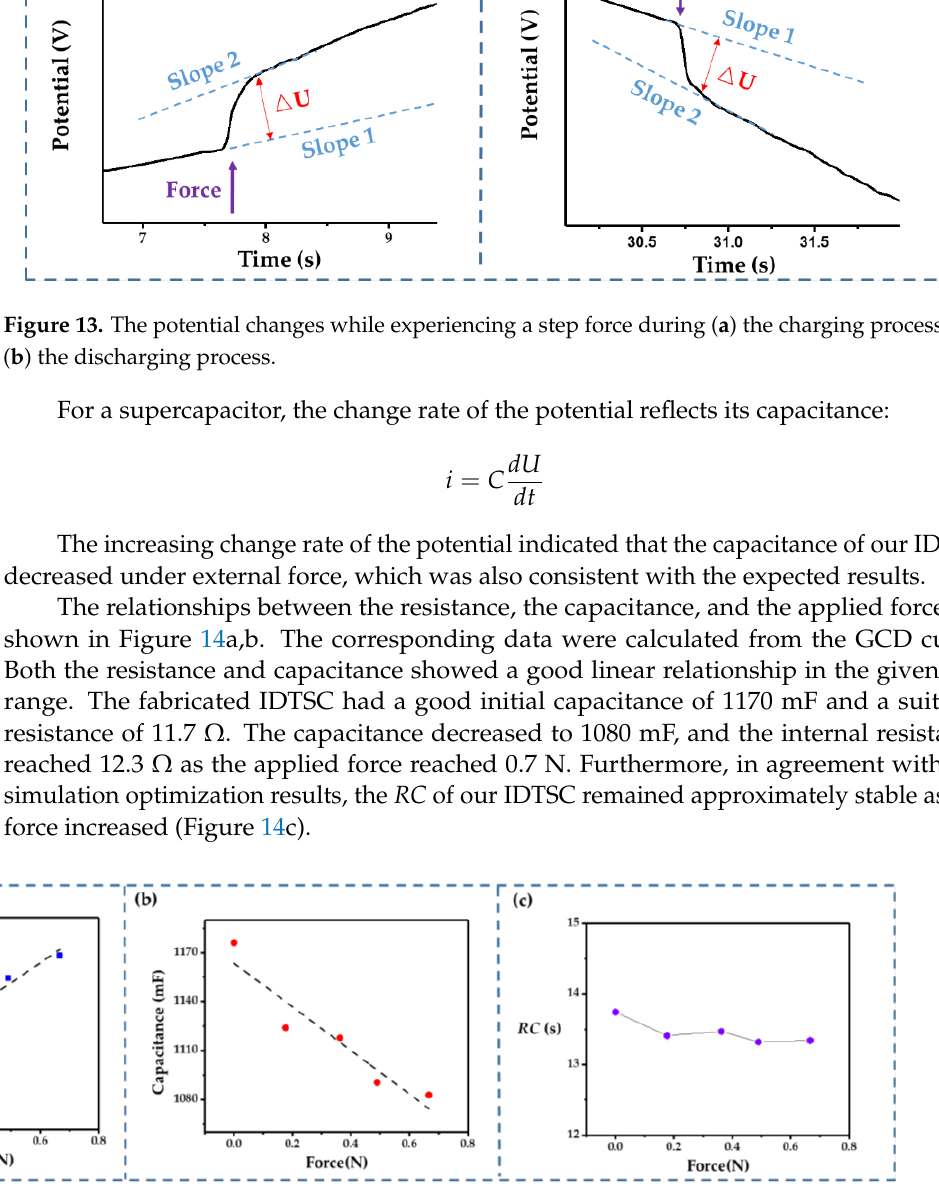
Figure 14. Test results: ( a ) resistance vs. external force. ( b ) capacitance vs. external force. ( c ) RC vs. external force.